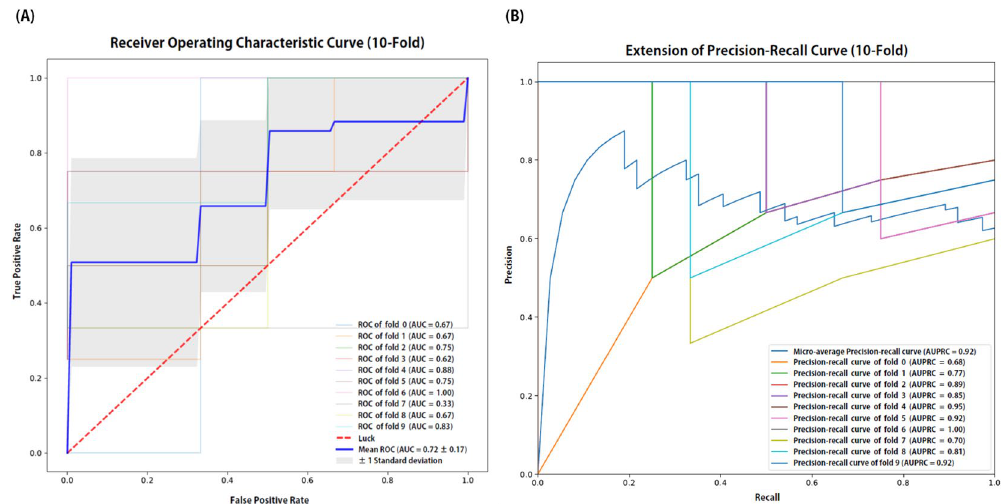
Figure 3. Receiver operating characteristic (ROC) and precision-recall curves from 10-fold internal validation in the training set (N = 59). Area under the ROC curve (AUC) and area under the precision-recall curve (AUPRC) values were also estimated in each fold and represented in graphs. Abbreviations: AUC, area under the curve of ROC curve; AUPRC, area under the precision-recall